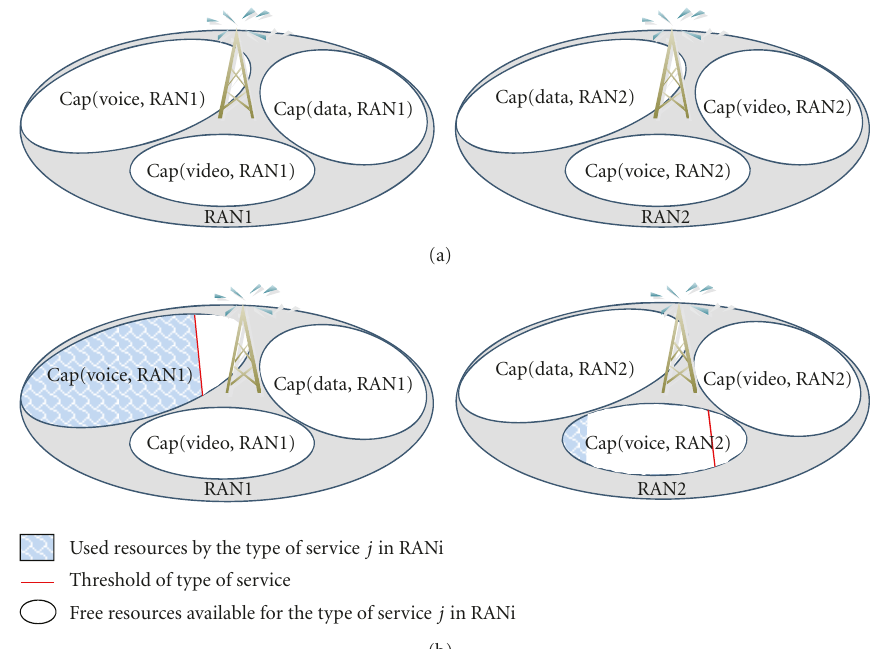
Figure 7: (a) Example of the distribution of radio resources on the type of services in two di ff erent RANs. (b) When the capacity of “Voice” service exceeds the specified threshold in RAN1, the voice tra ffi c is directed to